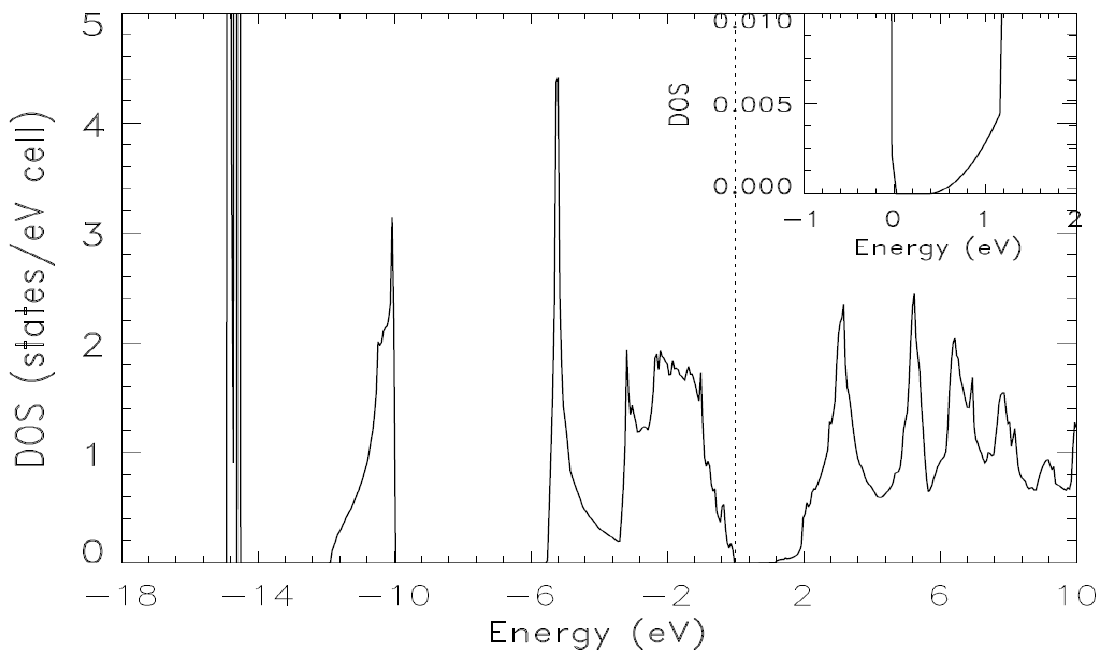
Figure 4. The calculated total density of states of zb-InAs, obtained from the energy bands in from Calculation IV. The zero on the horizontal axis indicates the position of the Fermi level. Table 3. Calculated, electronic energies of zb-InAs at high symmetry points in the Brillouin Zone obtained with the optimal basis set of Calculation IV. We used the experimental lattice constant of 6.0583 Å . This table is partly to enable comparisons with future room temperature, experimental and theoretical results.